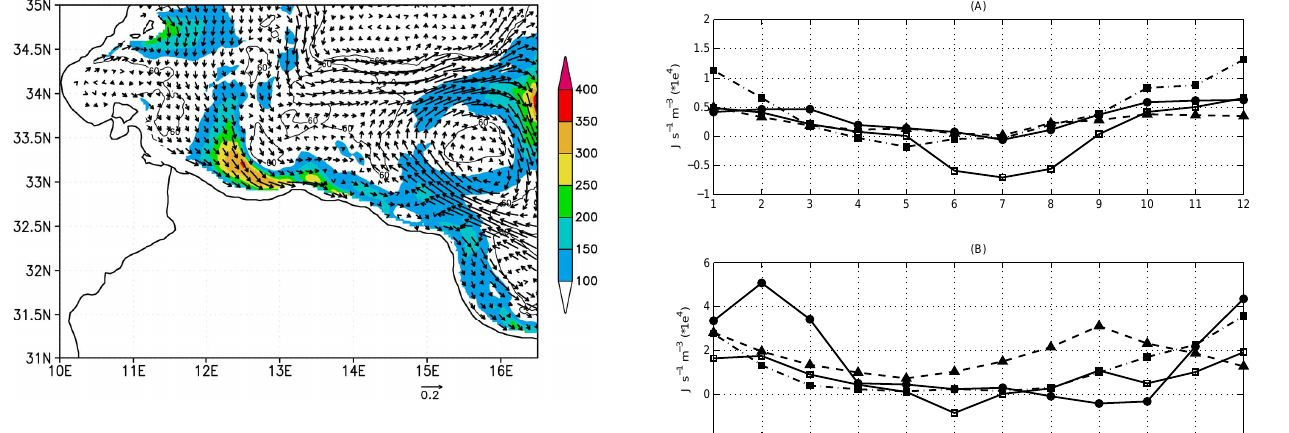
Fig. 13. Monthly mean map of EKE superimposed on the mean flow [ms − 1 ] in December over the Tunisian and Libyan areas.